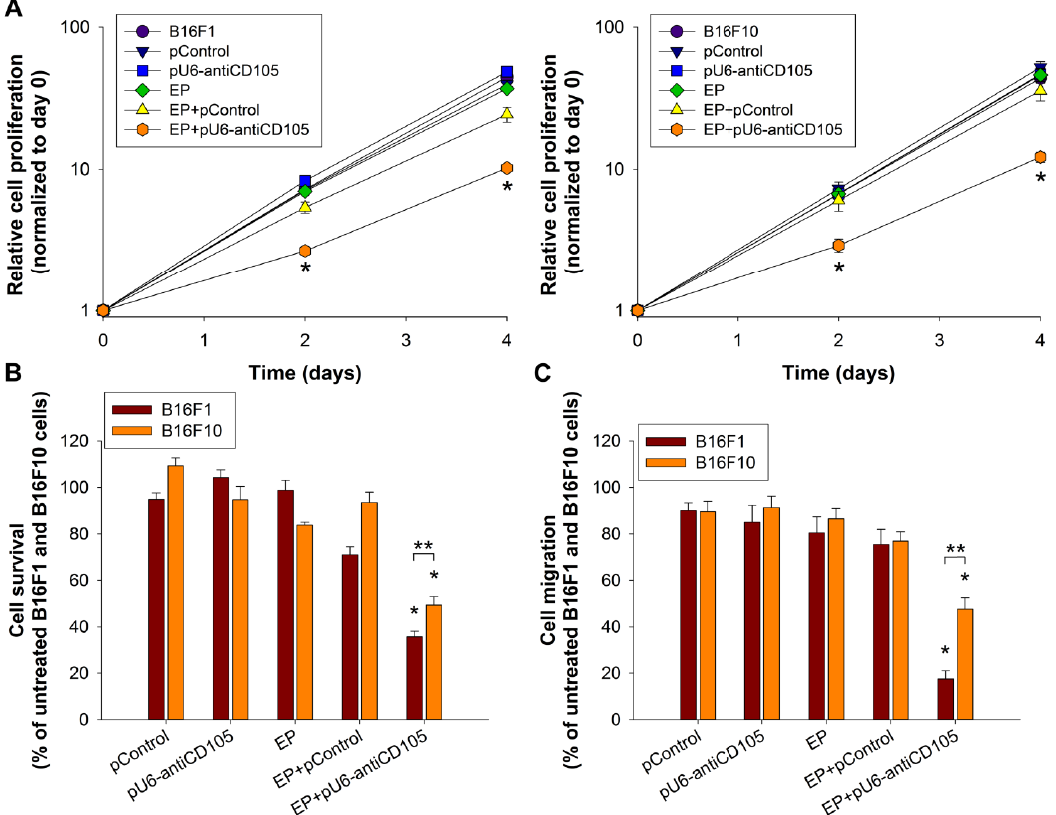
Figure 2. The biological properties of melanoma cells in vitro after endoglin silencing. ( A ) The proliferation, ( B ) survival and ( C ) migration of B16F1 and B16F10 cells after GET of pU6-antiCD105. All data for curves and bars are represented as arithmetic mean ± standard error of the mean. One asterisk indicates statistically significant differences between EP+pU6-antiCD105 and the control groups, and two asterisks between the B16F1 and B16F10 cell lines (* , ** p < 0.05). Two independent experiments were performed for each assay with n = 8 ( A ); n = 3 ( B ); n = 4 ( C ) replicates.